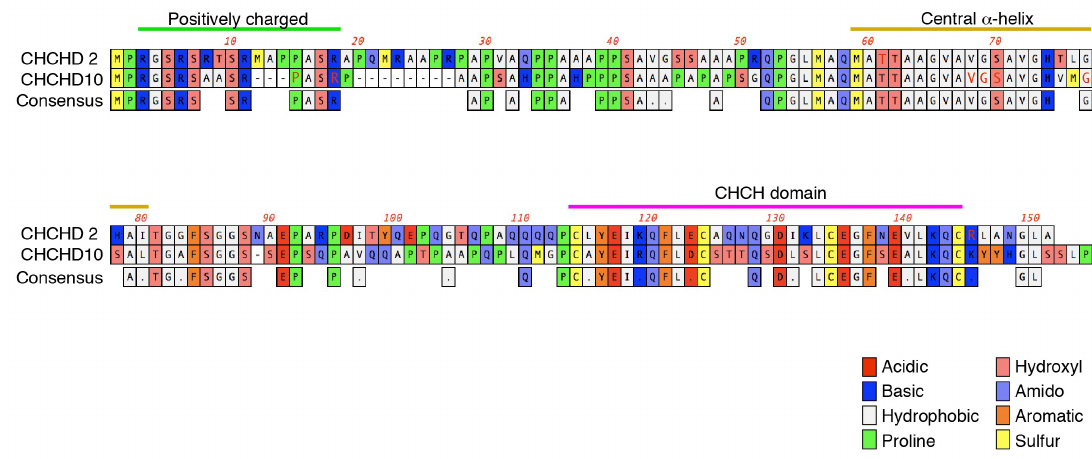
Figure 3. Alignment of human CHCHD2 and CHCHD10. N-terminal positively charged regions proposed as MTS, central α -helices, and CHCH domains are shown. Sequence alignment was performed by ClustalW program while α -helices and CHCH domains were predicted by the RaptorX program. Red letters in sequences indicate affected amino acids in neurodegenerative